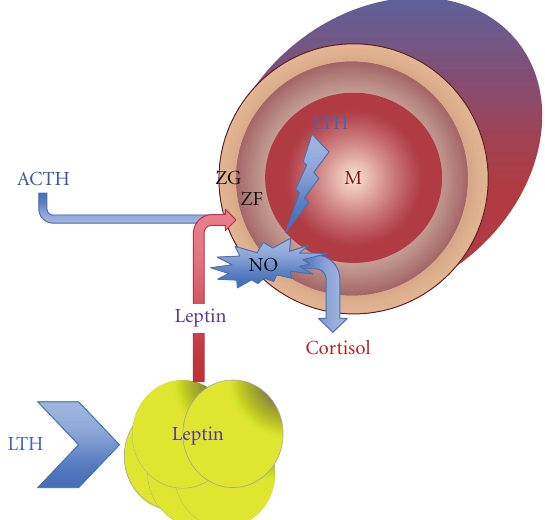
Figure 2: E ff ects of development under conditions of long-term hypoxia (LTH) on adrenocortical function in the late gestation ovine fetus. LTH increases perirenal adipose expression and release of leptin as well as adrenocortical leptin receptor (OB-Rb) expression. LTH also increases zona fasciculate-specific expression and activity of eNOS. Combined, leptin and nitric oxide (NO) serve to limit the ability of the elevated fetal plasma ACTH to stimulate cortisol production thus allowing for the maintenance of the normal ontogenic maturation of cortisol production preserving the prepartum exponential rise of this key steroid. In response to an acute secondary stress, these mechanisms allow release of cortisol synthesis thus resulting in an enhanced acute phase production of cortisol. (ZG-zona glomerulosa, ZF-zona fasciculata,